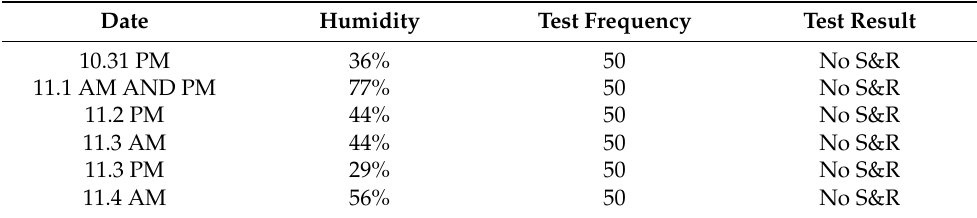
Table 5. Validation